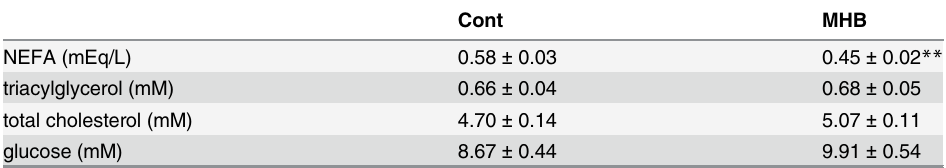
Table 2. Effect of MHB on plasma components in mice fed on HFD with or without MHB supplementation.